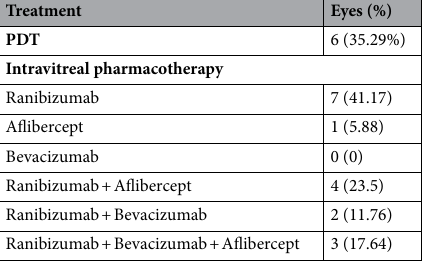
Table 4. Treatment of MLPED eyes. MLPED: multilayered pigment epithelial detachment; PDT: Photodynamic therapy.